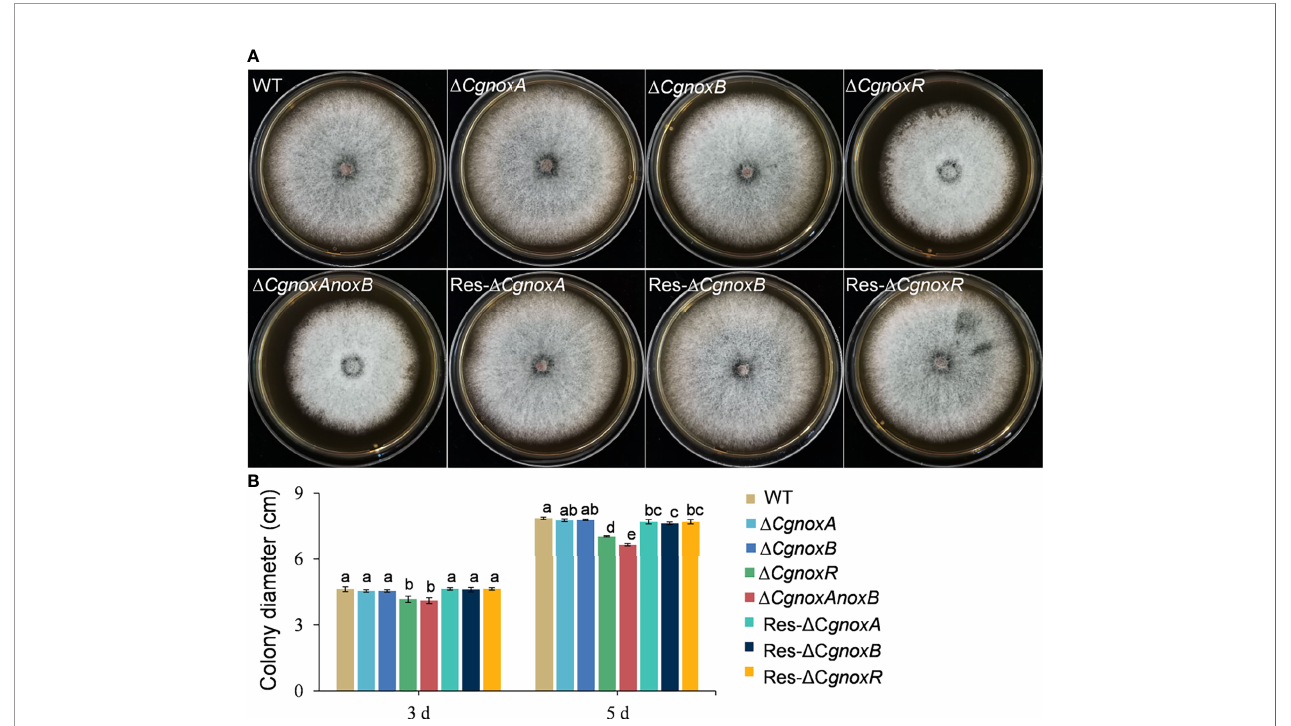
FIGURE 1 | Colony morphology and diameter of C. gloeosporioides strains cultured on PDA medium. (A) Colony morphology after growth on PDA for 5 days. (B) Colony diameter after growth on PDA for 3 and 5 days. Bars represent standard deviations